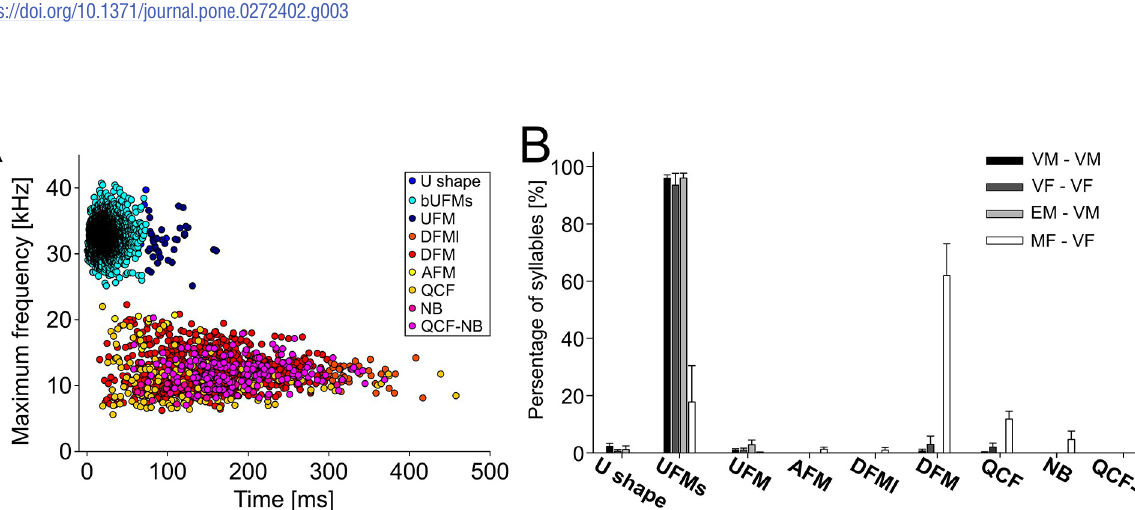
Fig 4. Vocalizations of gerbils during resident-intruder tests. (A) Maximum fundamental frequency and duration of each vocalization. High- frequency groups are represented by bluish symbols and low-frequency groups are represented by reddish symbols. (B) Percentages of each call type emitted during the resident-intruder test are